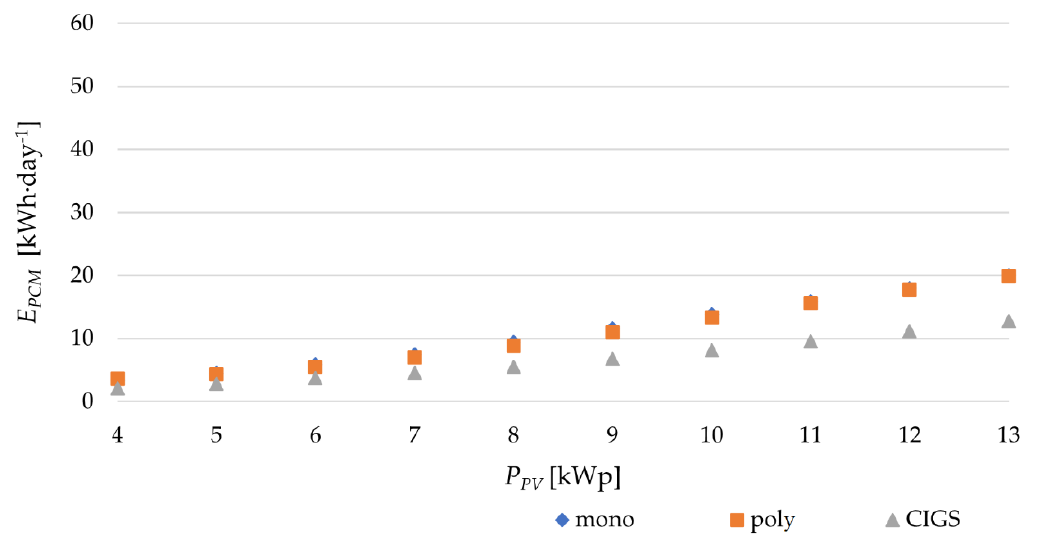
Figure 12. The amount of energy stored in the PCM battery as a function of the power of the PV plant for cloudy days.